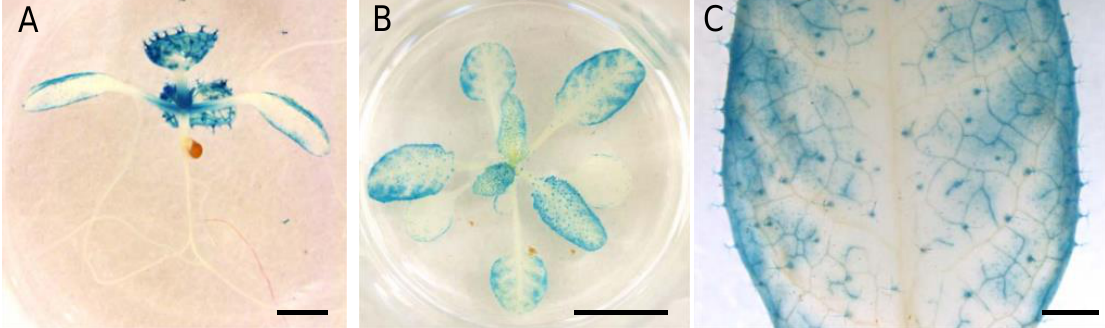
Figure 8. GUS staining of pNPF5.1:GUS plants. ( A ) A seedling (approximately 7-d-old) grown under continuous light. Scale bar = 1 mm. ( B ) Rosette leaves of plants grown under continuous light (approximately 3 weeks old). Scale bar = 1 cm. ( C ) Close-up view of a leaf in ( B ). Scale bar = 1 mm.